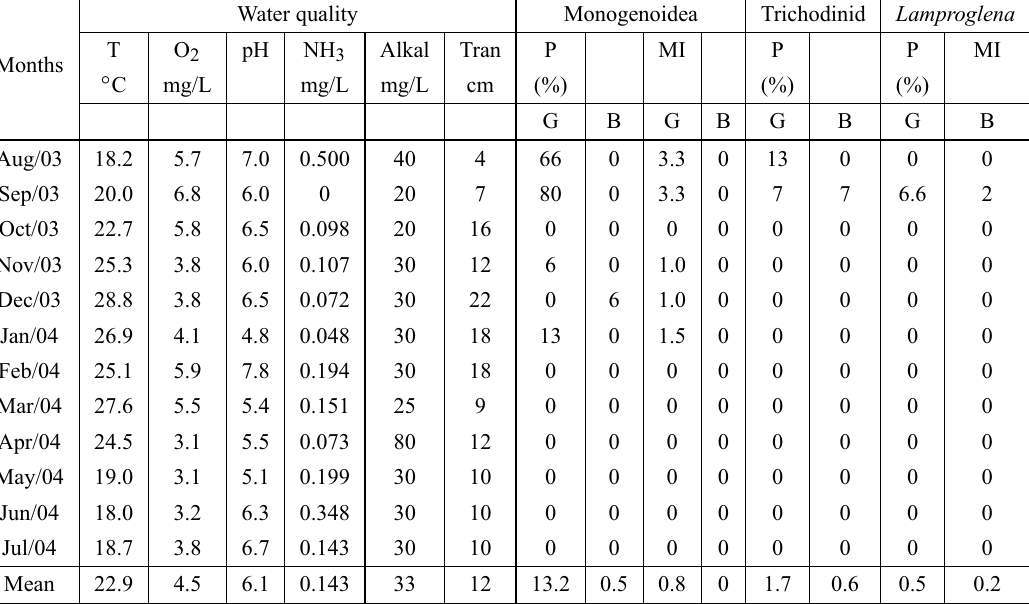
Water quality and parasitic characteristics of Nile tilapias (n=180) kept with swine dejects from Valley of Tijucas River, Santa Catarina, Brazil. T: temperature; O 2 : dissolved oxygen; NH 3 : ammonia; Alkal: alkalinity; Tran: transparency; P: prevalence; MI: mean intensity; G: gills; B: body